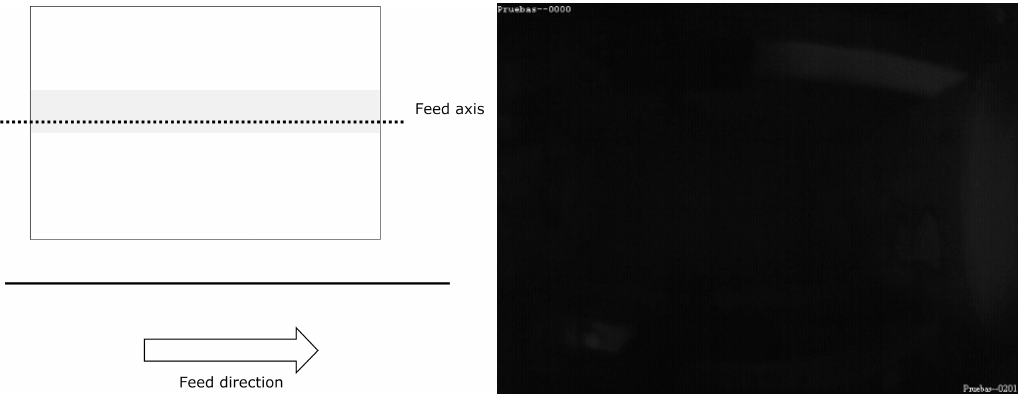
Figure 5. Natural order of activation with a forward direction from left to right.